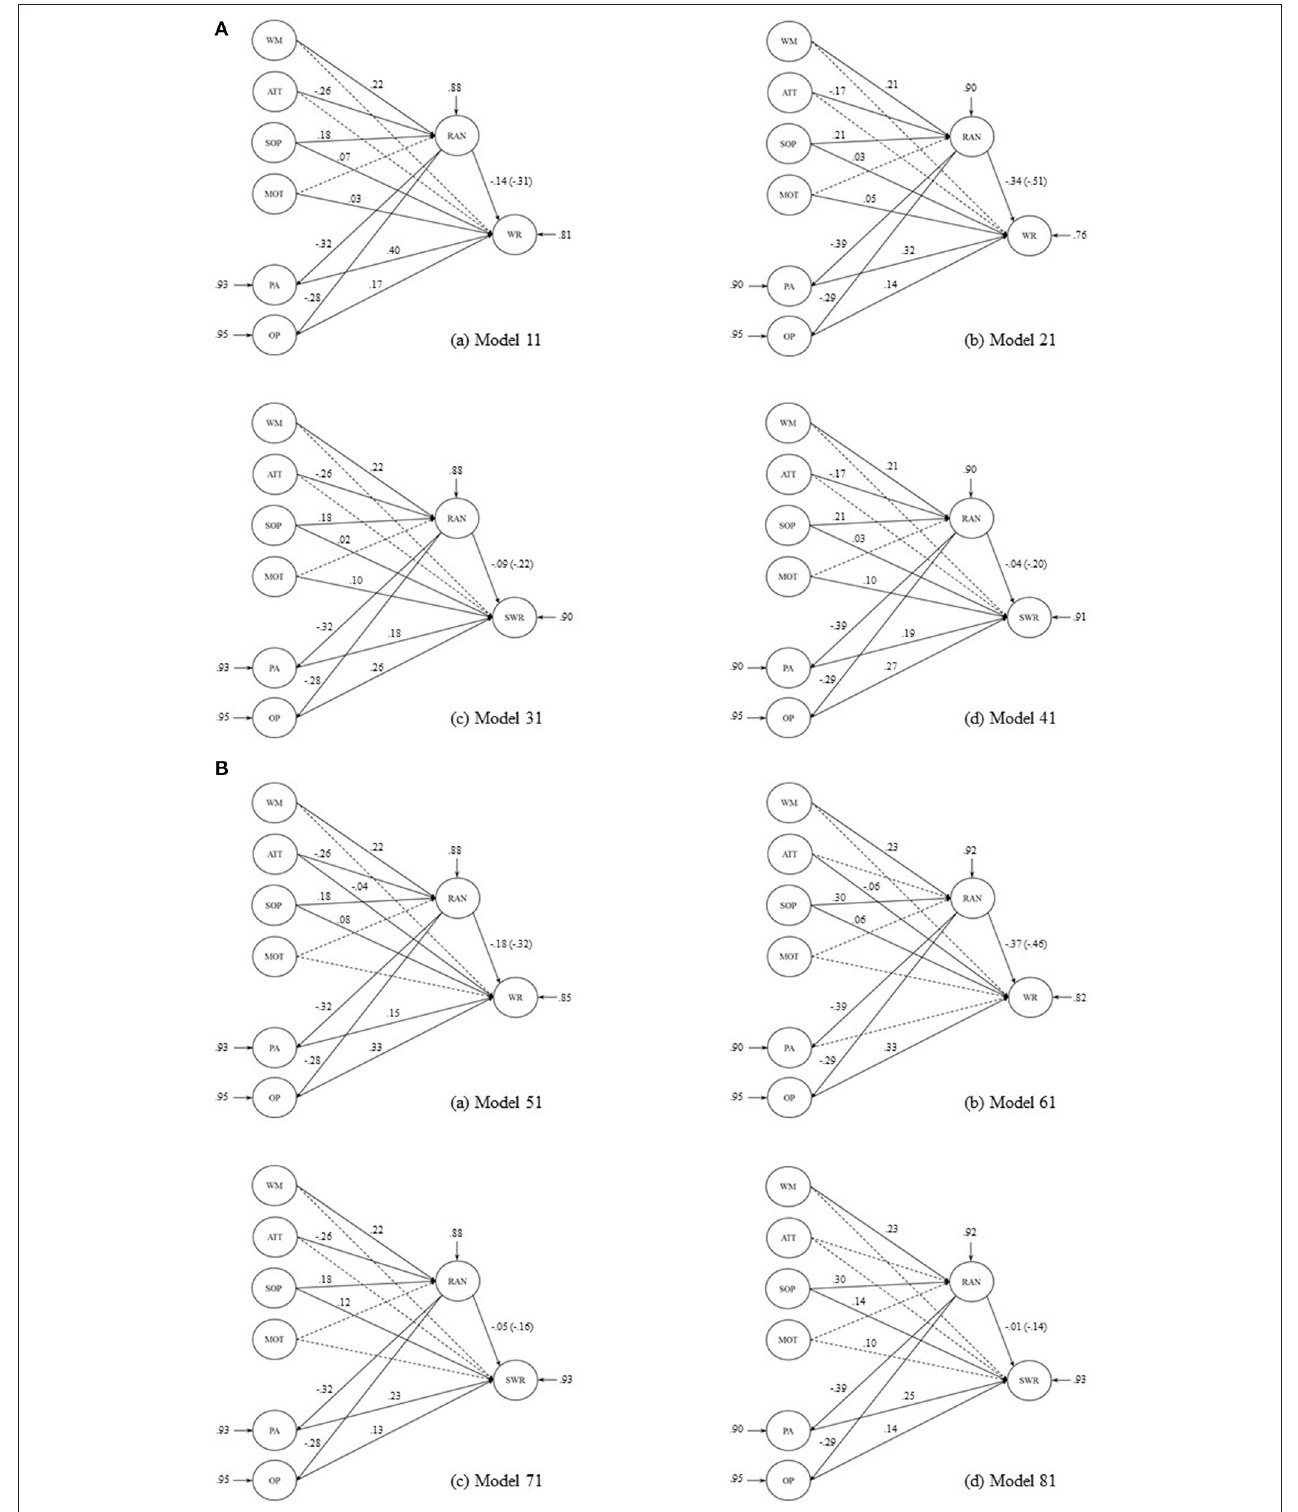
FIGURE 1 | (A) The first set of models testing the direct and indirect effects of RAN, mediated by phonological ability and orthographic processing, to oral (M11, M21) and silent (M31, M41) reading fluency, in the concurrent analysis. The circles represent the latent cognitive (RAN, working memory, attention, processing